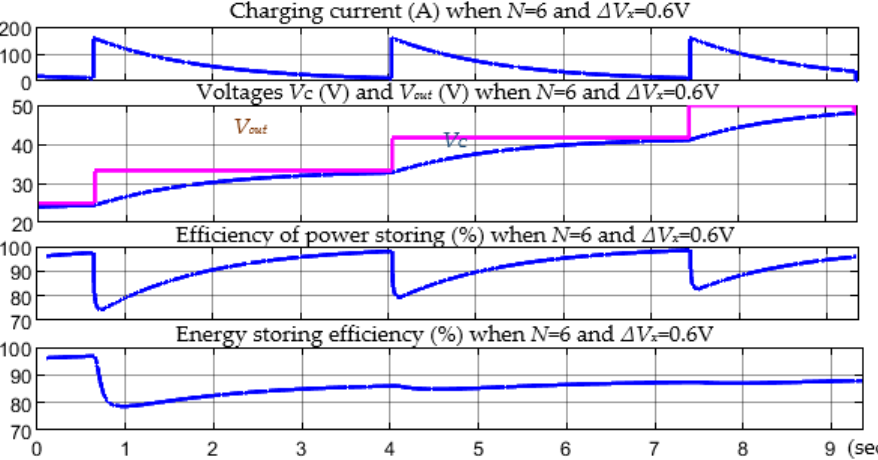
Figure 25. SC circuit charging current, voltage, and power storage efficiency during charging in the case of a six-phase converter and ∆ V x = 0.6 V.